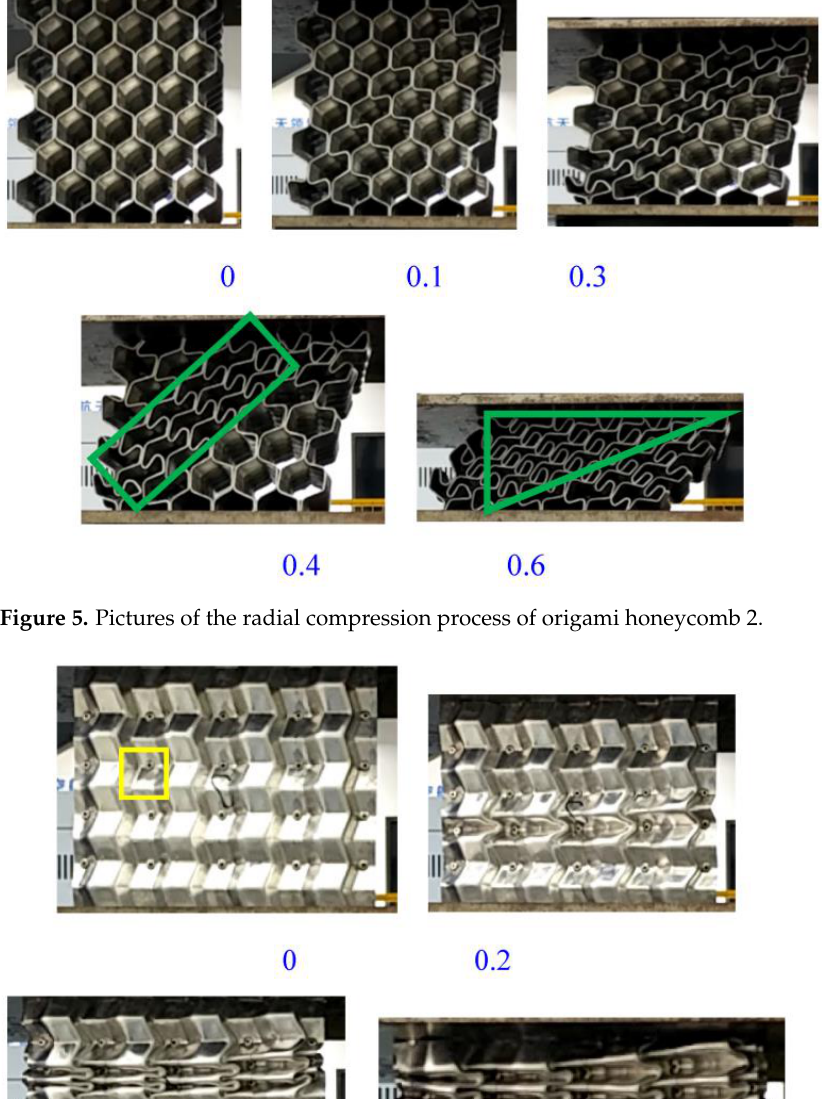
5 of 14 Figure 4. Pictures of the lateral compression process of origami honeycomb 1. In the radial compression of the welded origami aluminum honeycomb material, there was no cracking. When the material was compressed, deformation occurred first at the weakest hole, and the hexagonal holes gradually became denser in a similar way to collapse. Along the deformed holes, the material appeared to buckle and deformed grad- ually along a diagonal line, as shown in the green shapes in Figure 5; further, on the basis of the previous deformation, the upper-left half of the material deformed (green area). Then, the material was in a buckling state as a whole, and the material was dumped to one side until the holes were compacted. Deformation did not occur in the middle part of the material. This is because the middle part of the material was double-layered and was